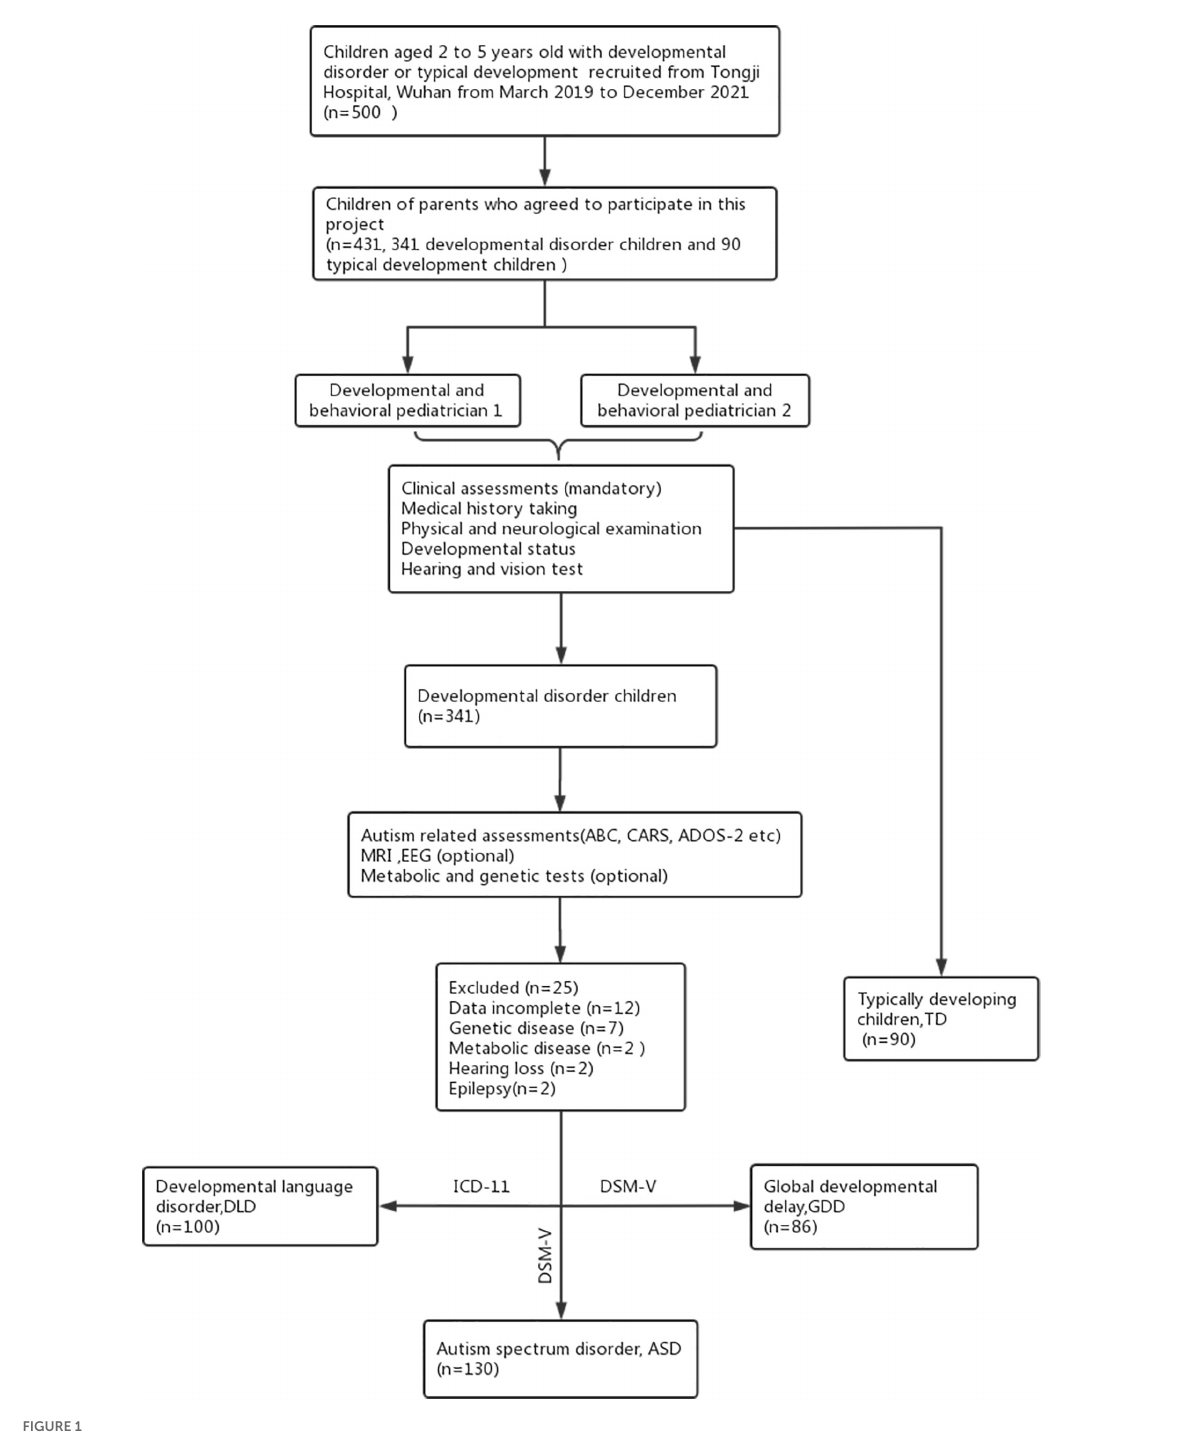
FIGURE1 Recruitment and diagnosis of participants.